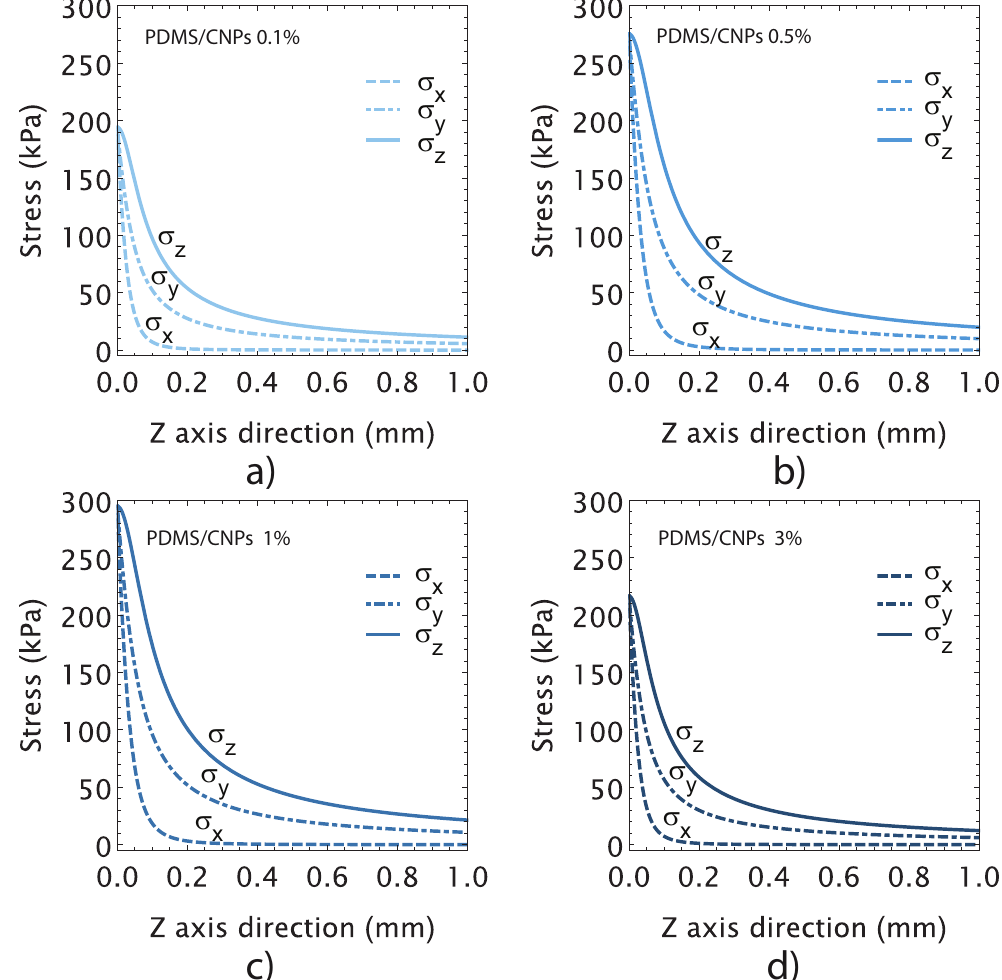
Figure 8. Stress-induced in the cylindrical active elements by NIR irradiation considering the op- timal distance and the optimal optical power output for each nanocomposite: ( a ) PDMS/CNPs 0.1% showing the state of the stress through z -axis direction considering an optimal distance d = 5 mm and 200 (mW); ( b ) PDMS/CNPs 0.3% showing the state of the stress through the z -axis direction considering an optimal distance d = 9 mm and 210 (mW); ( c ) PDMS/CNPs 1% showing the state of the stress through the z -axis direction considering an optimal distance d = 10 mm and 180 (mW); and ( d ) PDMS/CNPs 3% showing the state of the stress through the z -axis direction considering an optimal distance d = 16 mm and 230